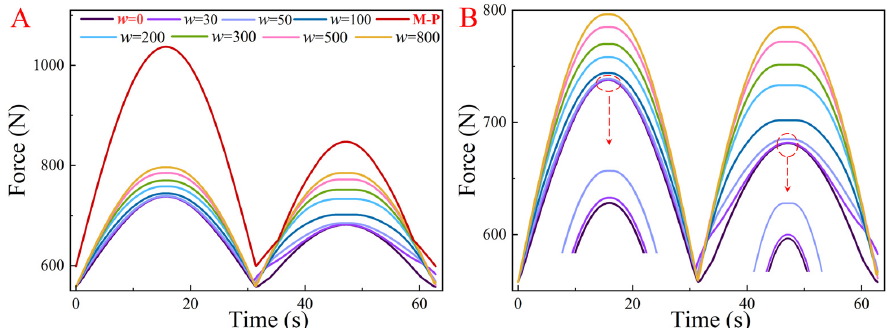
Figure 9. Driving force optimization results of MCPM( M = 2, N = 2) using different optimization methods: ( A ) overall view and ( B ) partial enlarged view.